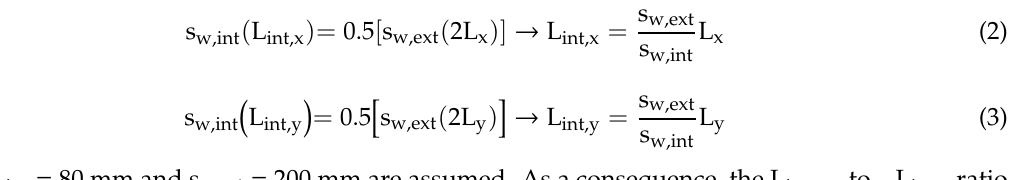
Table 3. Definition of the repair cost for interior infill partitions starting from the costs of exterior infills. C TOT DS1 C TOT DS2 (Hollow + Hollow) Panel without Openings: Exterior Infill Sca ff olding with steel sca ff olding and multi-directional ring-lock rosettes, with fiberglass monofilament netting for sca ff olding